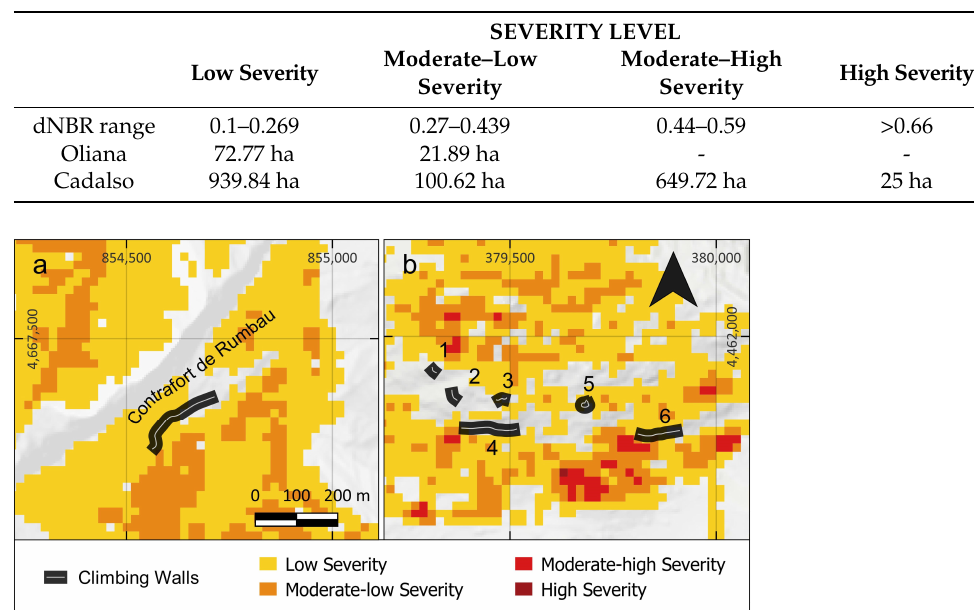
Figure 5. Land cover vegetation in Oliana ( a ) and Cadalso ( b ) partially burned by wildfires. Source: Adapted from [37]. Table 1. Burn severity levels obtained by calculating the differenced Normalized Burn Ratio (dNBR) proposed by the United States Geological Survey (USGS) ([38,39]).